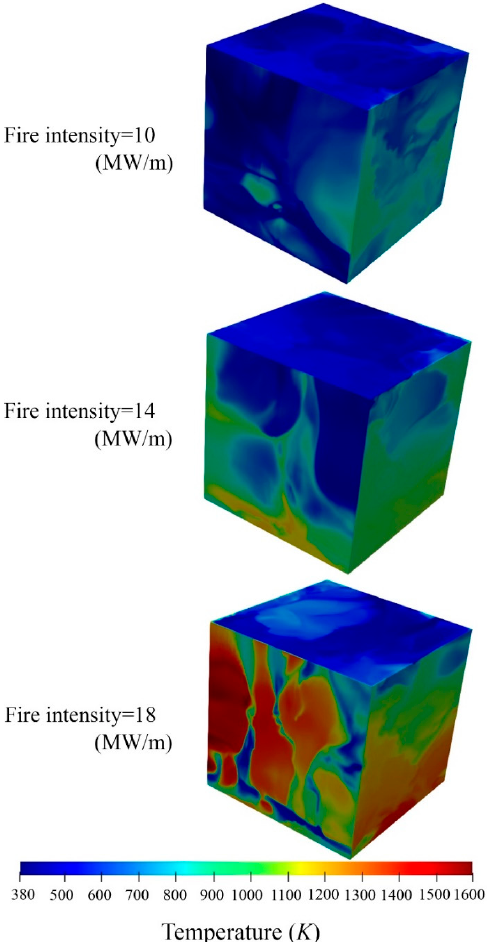
Figure 9. Temperature distribution on the building for three different fire intensity values. Fire 2022 , 4 , x FOR PEER REVIEW